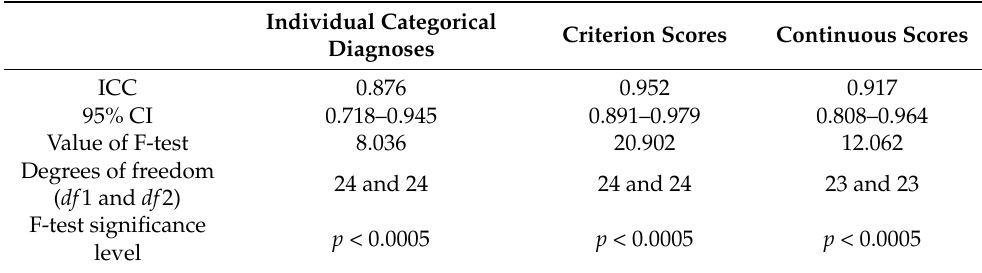
Table 1. Intra-class correlation coefficients with results of